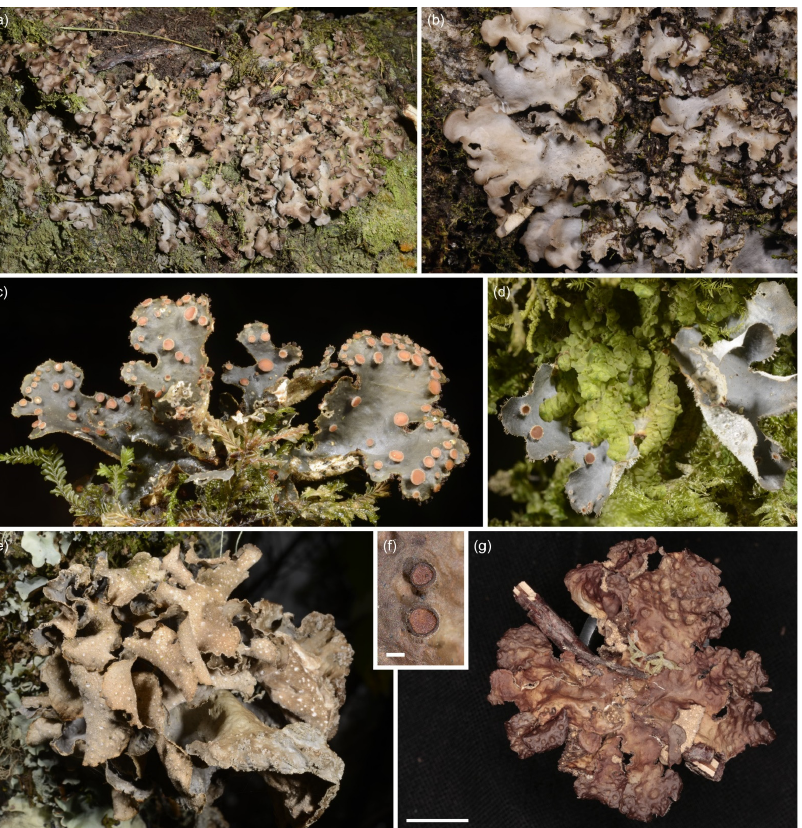
Figure 13. Sticta sublimbata , Sticta tomentosa , and Sticta umbilicariiformis . ( a , b ) Sticta sublimbata . ( a ) Large and adnate thallus of specimen JR16275 photographed in situ on Sagalla Mountain. ( b ) Specimen JRCA2 photographed in situ in Ngangao Forest displaying characteristic rounded lobes and marginal soralia. ( c , d ) Sticta tomentosa photographed in situ on Vuria Mountain. ( c ) Specimen JR16368 with palmate lobes and abundant apothecia. ( d ) Specimen JRA14357 showing the lobe margins with tufts of hair, apothecia with white hairs on the margin, and white lower surface with prominent cyphellae. ( e – g ) Sticta umbilicariiformis . ( e ) Specimen JR16102 photographed in situ in the ericaceous zone on Mt. Elgon with characteristic pustules on thallus margins and submarginal lamina. ( f , g ) Fertile specimen UK171411c with strongly foveolate upper surface and tomentose apothecial margins. Scales 0.5 mm in ( f ), 1 cm in ( g ).